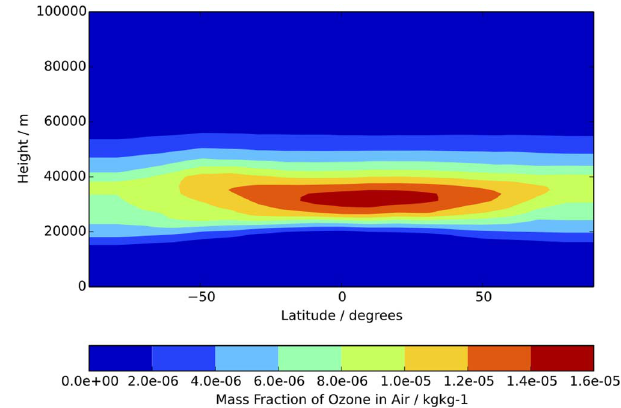
Fig. 4. A zonal mean pro fi le produced to prescribe the initial con fi guration of atmospheric ozone for the 100 km model lid. Its inclusion is important in order to represent the correct vertical temperature structure (via